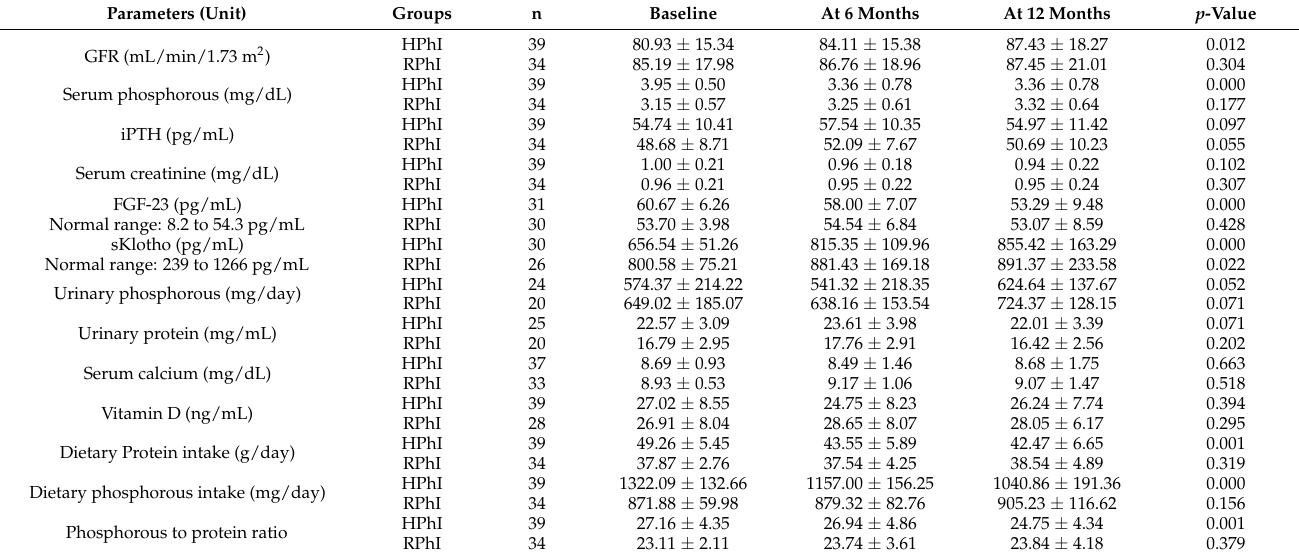
Table 8. Comparisonofbiochemicalparametersbeforeandafterdietarycounsellinganddietaryintervention.